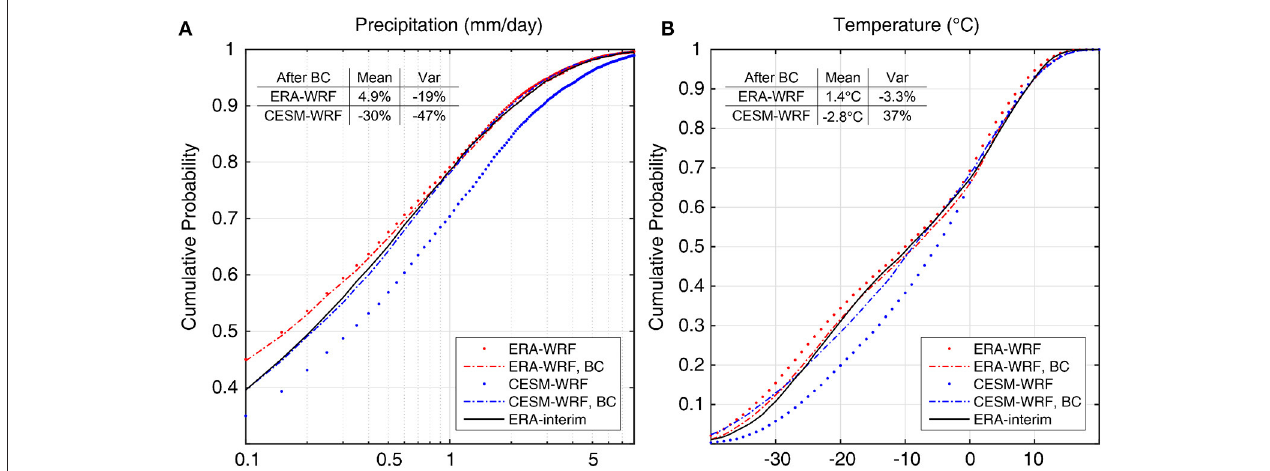
FIGURE 6 | The comparisons of cumulative probabilities of (A) daily precipitation (mm/day) and (B) air temperature ( ◦ C) over coastal and foothill domain. Products are from the downscaled ERA-WRF (red dots), bias-adjusted downscaled ERA-WRF (red dash-dot lines), downscaled CESM-WRF historical product (blue dots), and bias-adjusted downscaled CESM-WRF historical product (blue dash-dot lines). The reference is represented by ERA-interim (black solid lines). Changes in the mean value and variance after bias adjustments are in percentage, except for mean air temperature that shows absolute changes in ◦ C. Linear scaling adjusts biases more effectively in precipitation than in air temperature, and more so in CESM-WRF compared to